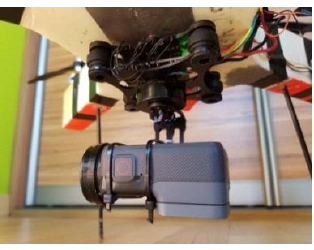
Figure 3. The method of attaching the three-axis gimbal together with the GoPro Hero 5 camera to the discussed multirotor–Unmanned Aerial Vehicle (UAV).